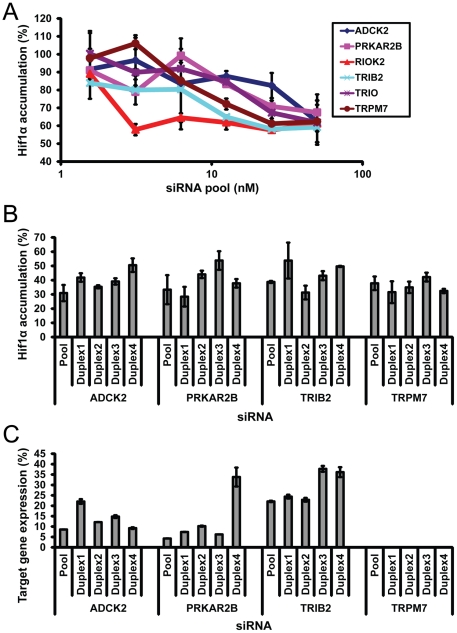
Validation of siRNAs targeting selected hit candidates.(A) Selected siRNAs decrease TNFα-mediated HIF-1α accumulation in a concentration dependent maner. (B) siRNA pools and individual siRNA molecules produced comparable effects on HIF-1α accumulation. (C) siRNA pools and individual siRNA molecules for the selected hit candidates provide effective target gene depletion. U2OS cells were incubated with TNFα for 24 hr. All data normalized to cells transfected with control siRNA NTC1. Data are representative of two independent experiments, three (A,B,Median+/−MAD) or two (C, Mean+/−STDEV) individual transfections each.